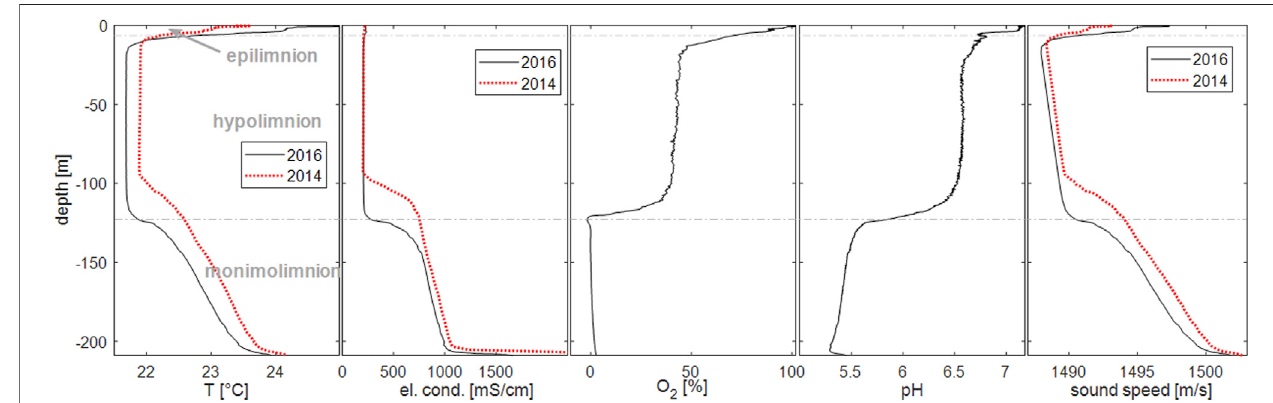
FIGURE2| Pro fi lesoftemperature,electricalconductivityat25 ° C,oxygensaturation(calibratedonlocalconditions),pHandsoundspeedmeasuredinLakeNyos on 2016-03-19 in comparison with measurements in 2014 [2014 data from Saiki et al. (2017): broken red lines]. The broken horizontal line indicates the depth of the major chemical gradient, the so-called